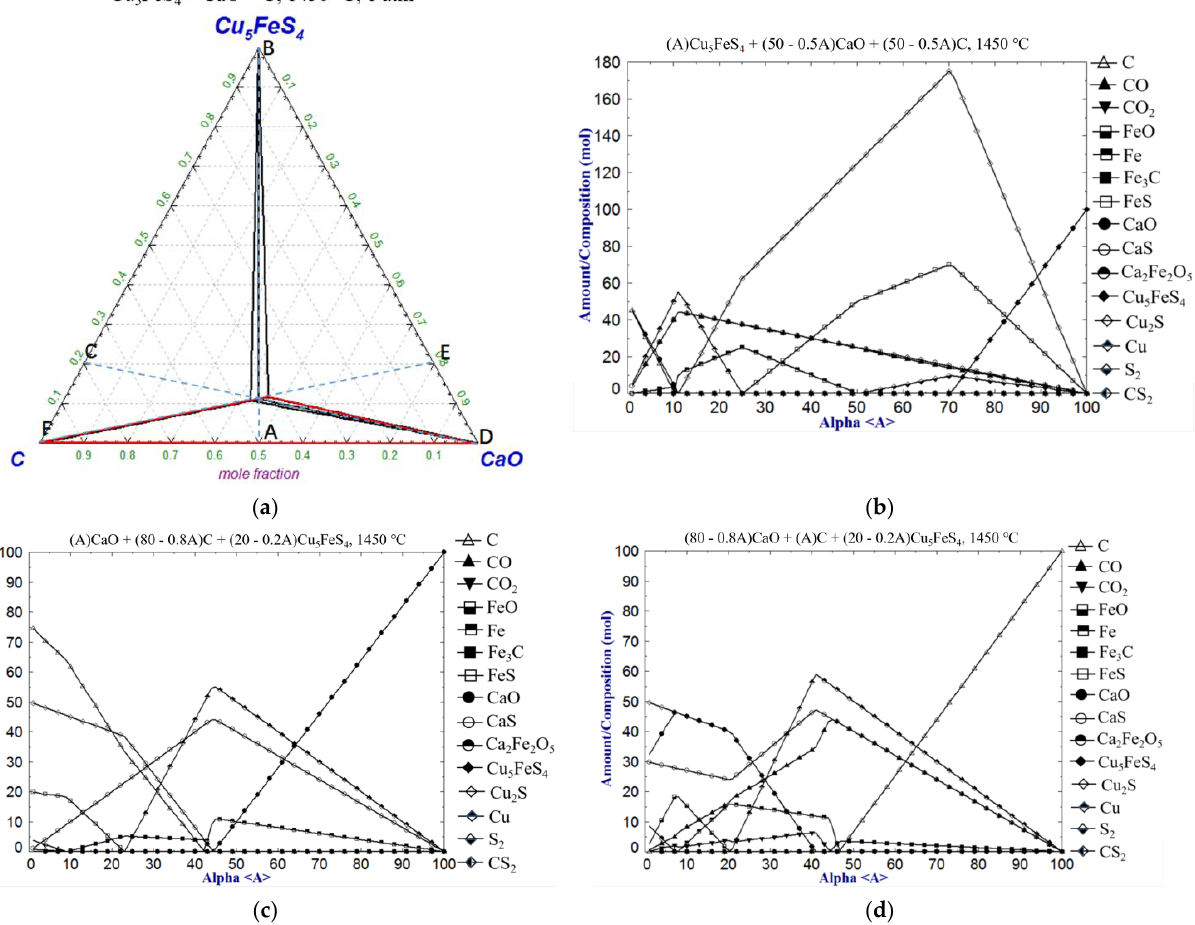
Figure 7. Phase diagram ( a ) and equilibrium composition of sulfide ( b ): the compositions varie along the AB line, ( c ): the compositions varie along the CD line, ( d ): the compositions varie along the EF line.